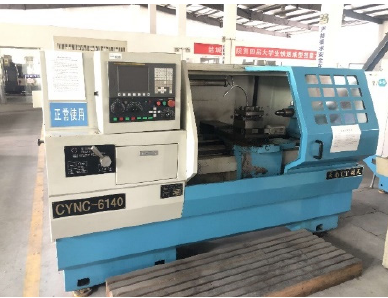
Figure 4. NYC-6140 numerically controlled machine tool.